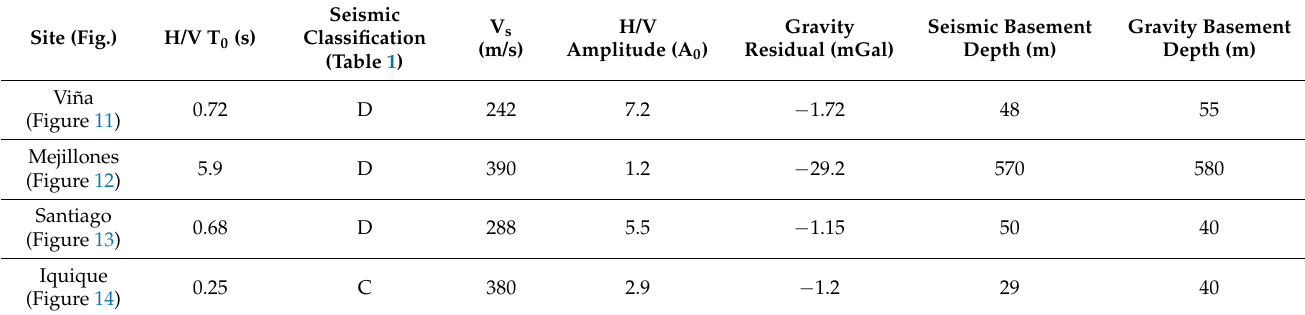
Table 2. Summary of the comparison between seismic and gravity basement for the four sites studied. Site (Fig.) H/V T 0